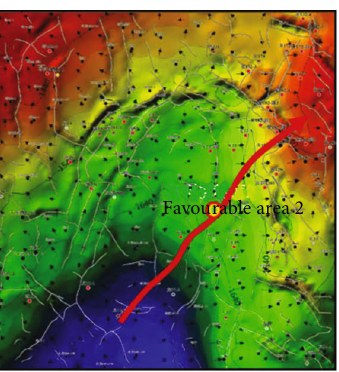
Figure 10: Favorable area 2 migration trend controlled by pale